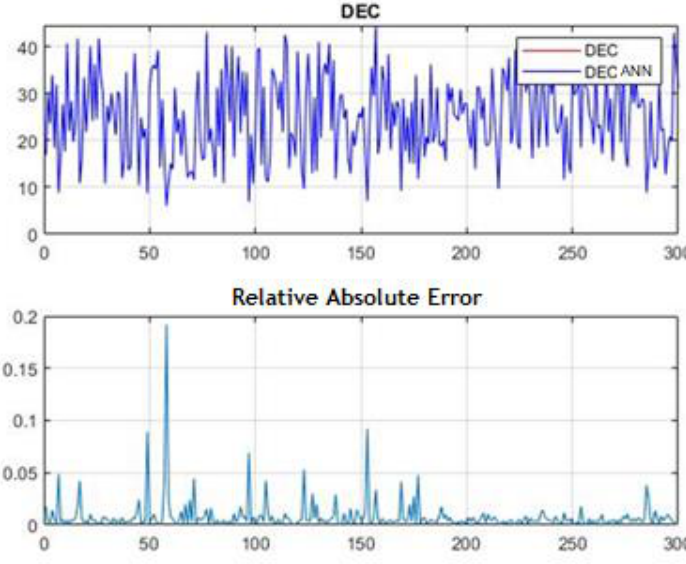
Figure 4. ANN DEC model output.